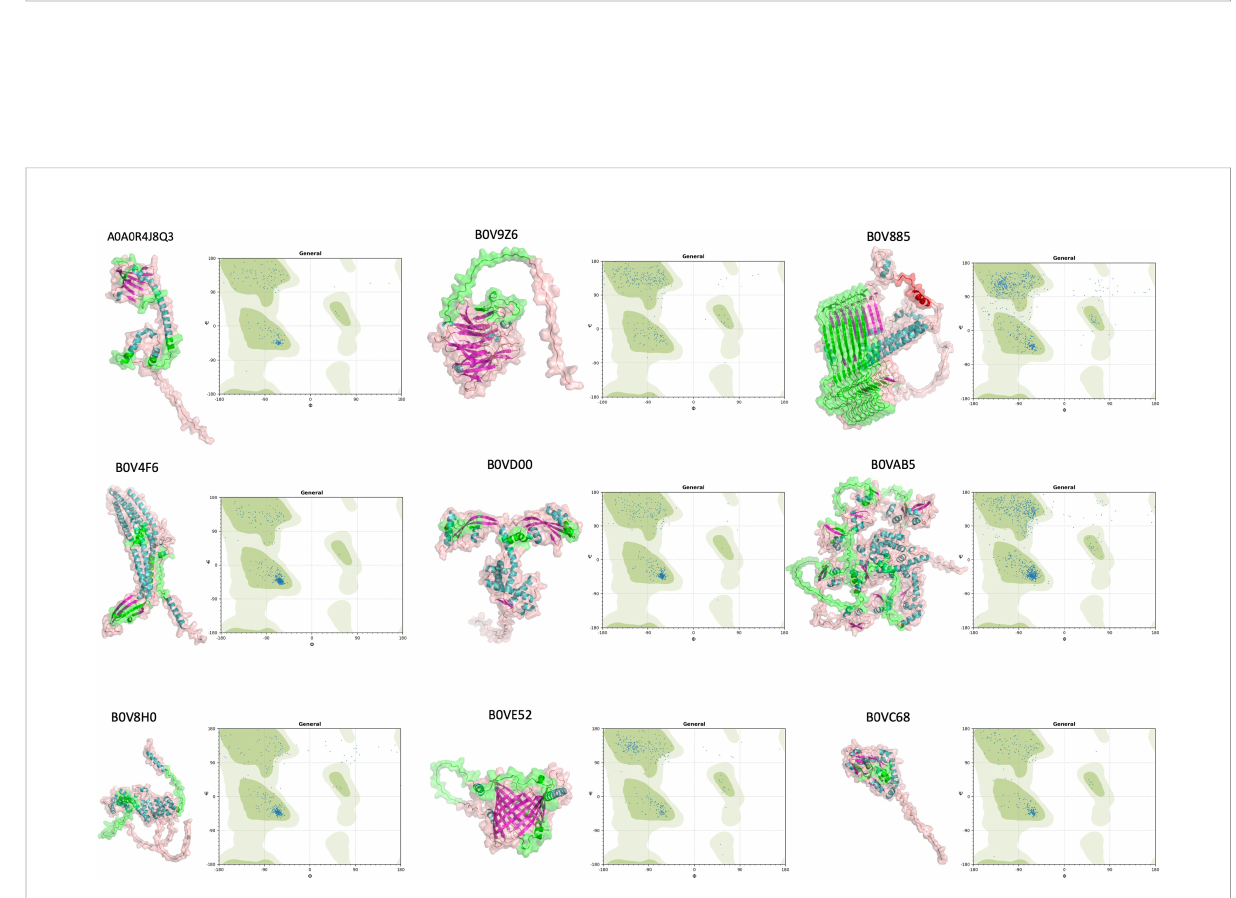
FIGURE 4 Tertiary structure prediction of nine selected proteins (A0A0R4J8QA3, B0V9Z6, B0V885, B0V4F6, B0VD00, B0VAB5, B0V8H0, B0VE52, and B0VC68) by AlphaFold v2.1.0. IEDB predicted B-cell epitope regions were overlapped and highlighted with green labeling. Ramachandran plots of these proteins were also depicted for the presentation of alpha-helix and beta-sheet distribution.